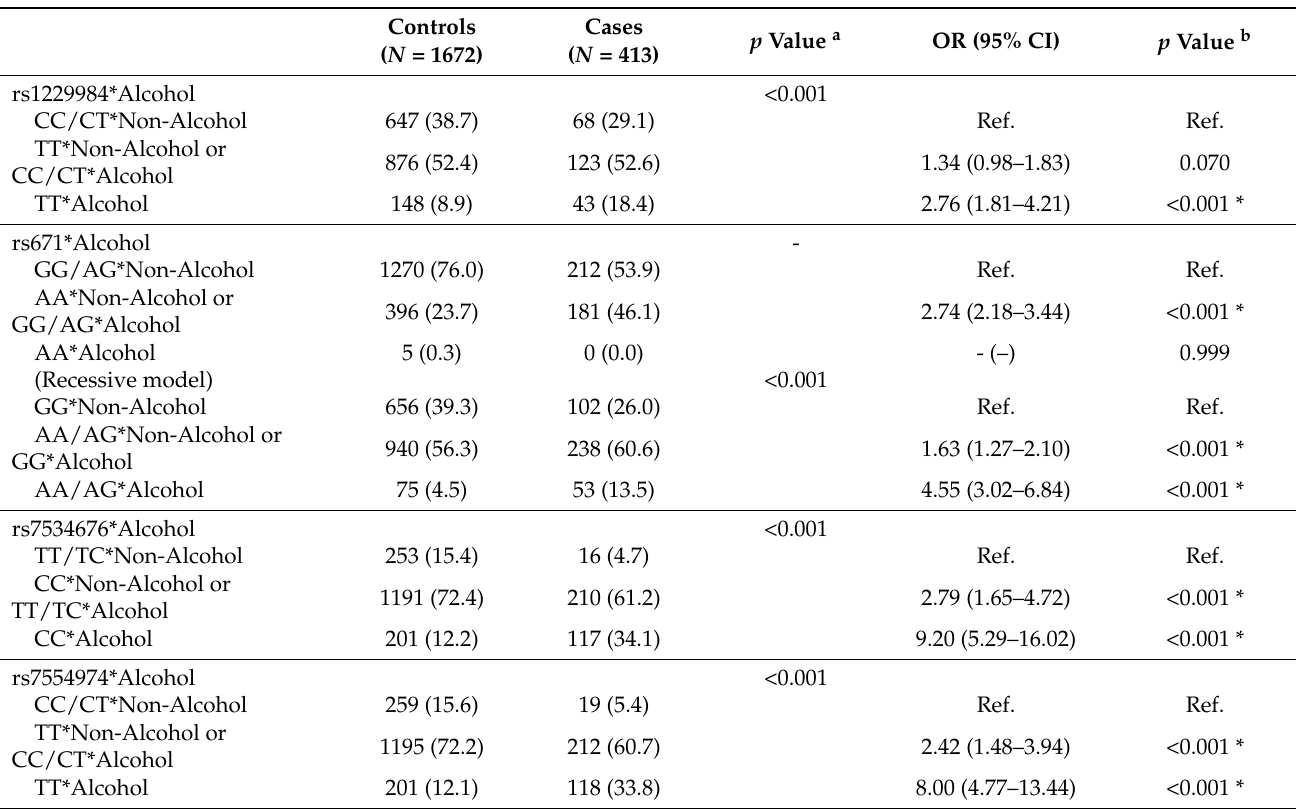
Table 5. Effects of interactions between SNPs and alcohol consumption on nasopharyngeal carcinoma